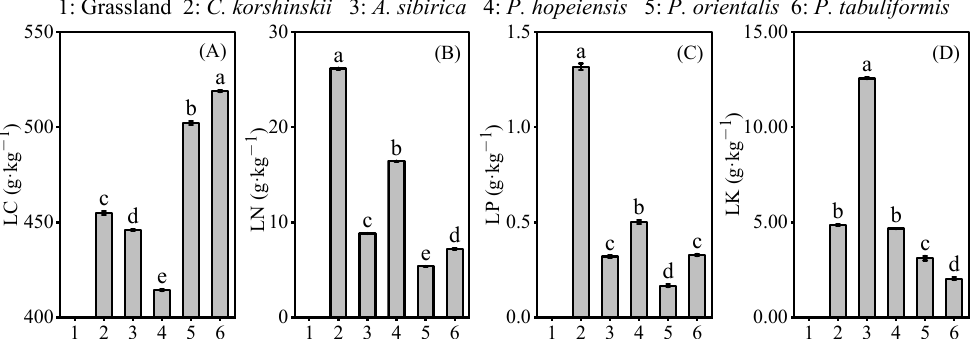
Forests 2021 , 12 , x FOR PEER REVIEW Figure 2. ( A – D ) Indicate different small panels, which are 4 litter chemical properties. Comparison of the chemical Figure 2. Comparison of the chemical properties of litter from different tree species. LC, litter car- properties of litter from different tree species. LC, litter carbon; LN, litter nitrogen; LP, litter phosphorus; LK, litter potassium. bon; LN, litter nitrogen; LP, litter phosphorus; LK, litter potassium. Different lowercase letters indi- cate significant differences among the five tree species ( p < 0.05). Different lowercase letters (a–e) indicate significant differences among the five plantations ( p < 0.05).